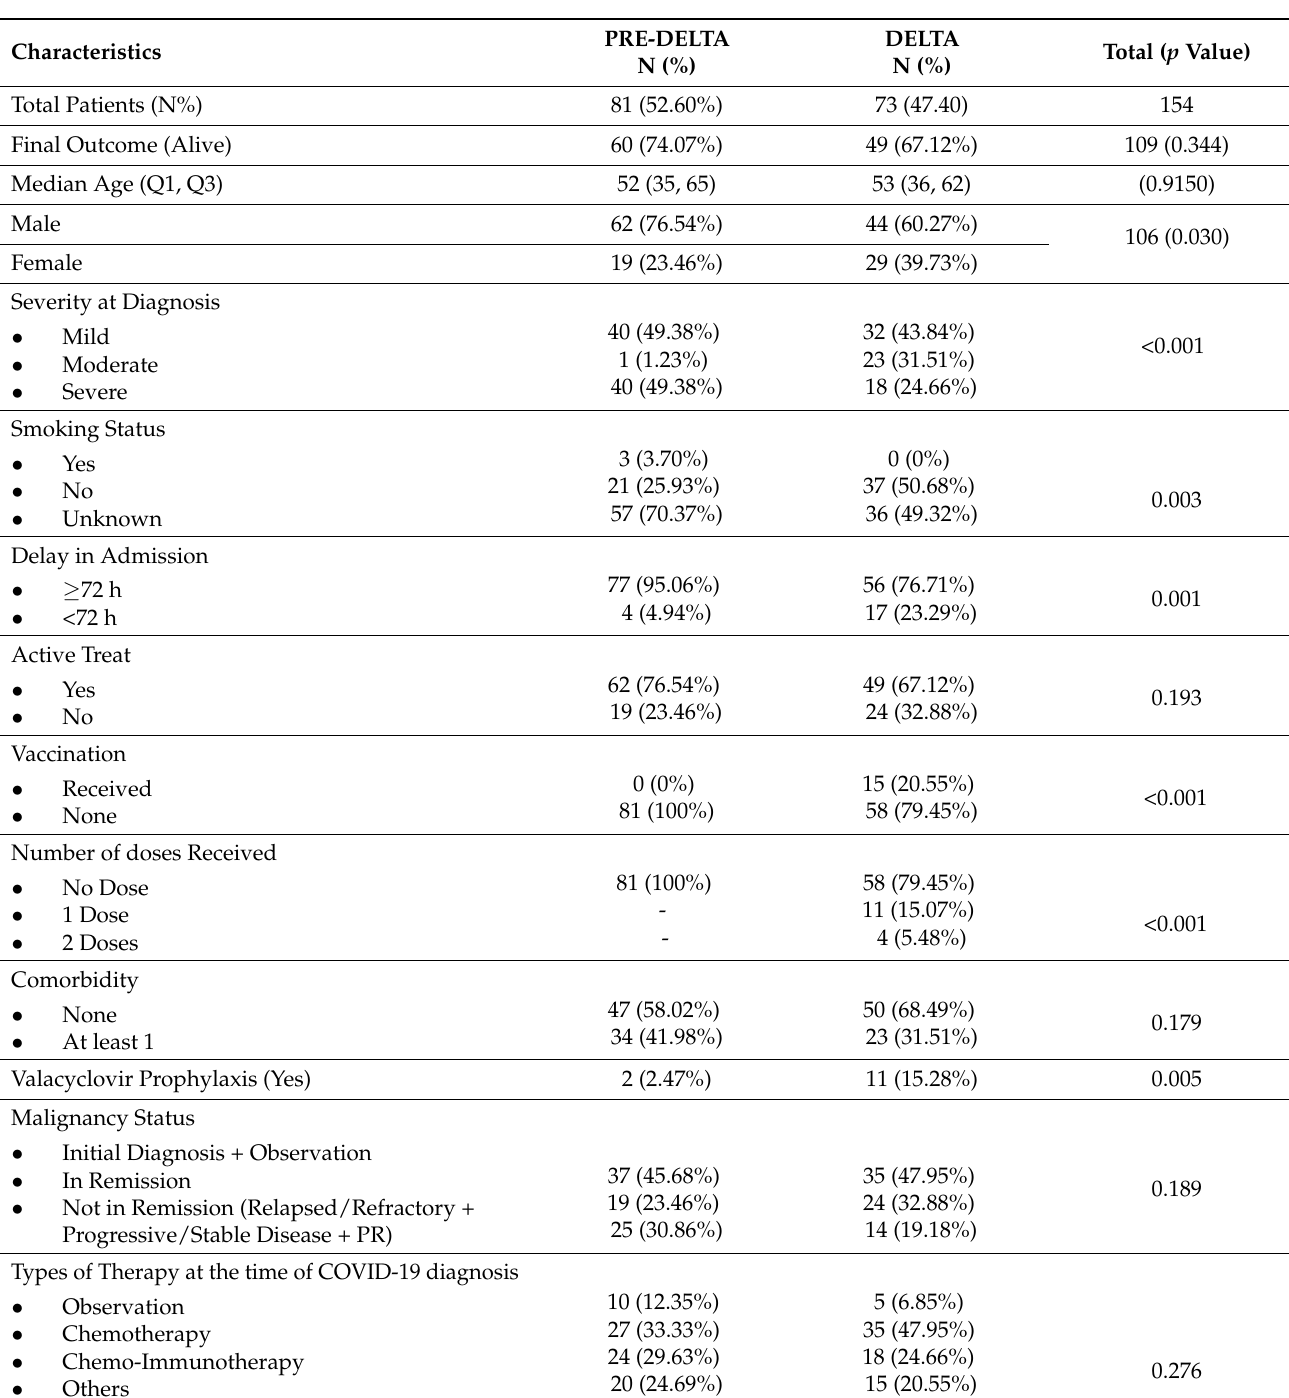
Table 1. Baseline characteristics of pre-delta and delta